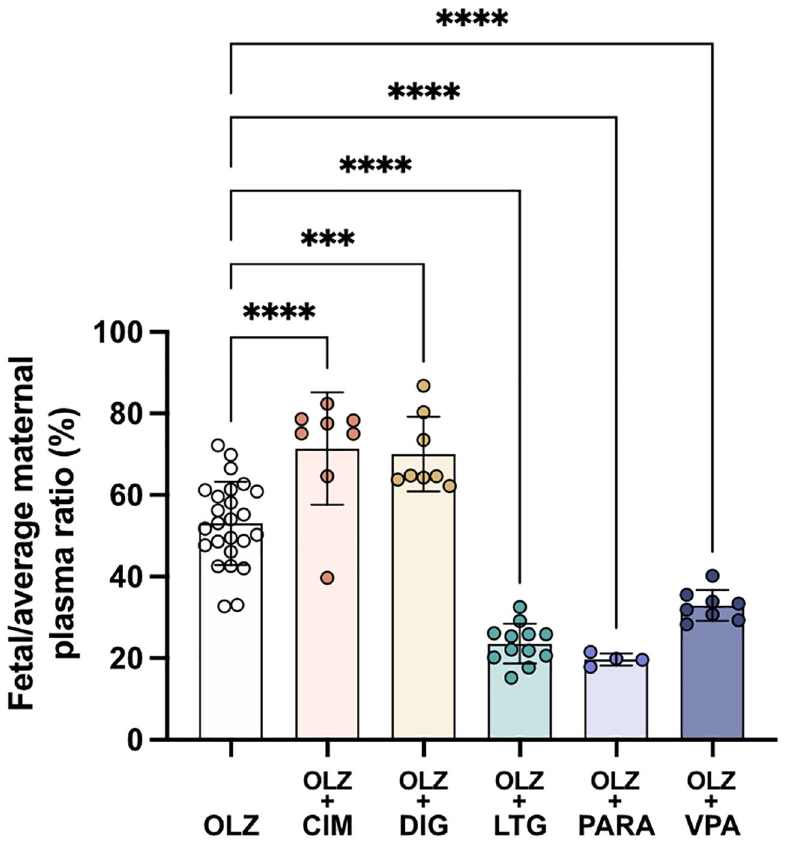
Figure 10. Transfer of [ 3 H]-olanzapine across the placenta. Calculated by fetal/average maternal plasma ratio (%) after a single intravenous ( i.v. ) injection either as monotherapy or in combination with: cimetidine (CIM, 11 mg/kg), digoxin (DIG, 0.03 mg/kg), lamotrigine (LTG, 6 mg/kg), paracetamol (PARA, 15 mg/kg) or valproate (VPA, 30 mg/kg). Bars are means (cid:3) SD. Note each point is an individual animal (n=4 – 26). ***p<0.001, ****p<0.0001. 81 (cid:3) 9% (n=20) in olanzapine monotherapy to 53 (cid:3) 5% (n=4) in combination therapy, p<0.05 (Figure 9). The other drugs co-administered with olanzapine did not appear to affect its entry at this age. Transfer of olanzapine across the placenta from maternal to fetal circulation changed significantly following co-administration with all of the drugs investigated (Figure 10). Cimetidine and digoxin co-treatment increased olanzapine transfer across the placenta from 53 (cid:3) 10% to around 70% (both n=8, p<0.0001 and p<0.001 respectively)